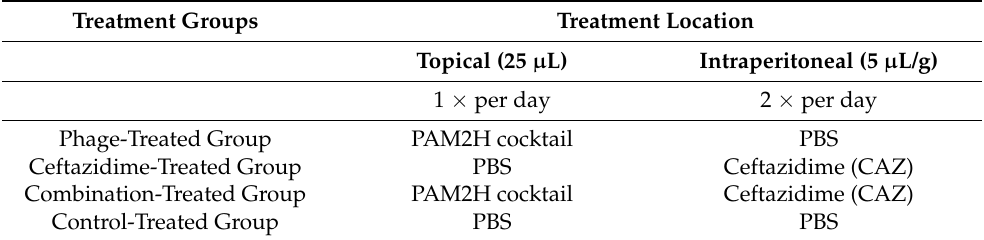
Table 7. Treatment type and frequency for mouse groups infected with PAO1::